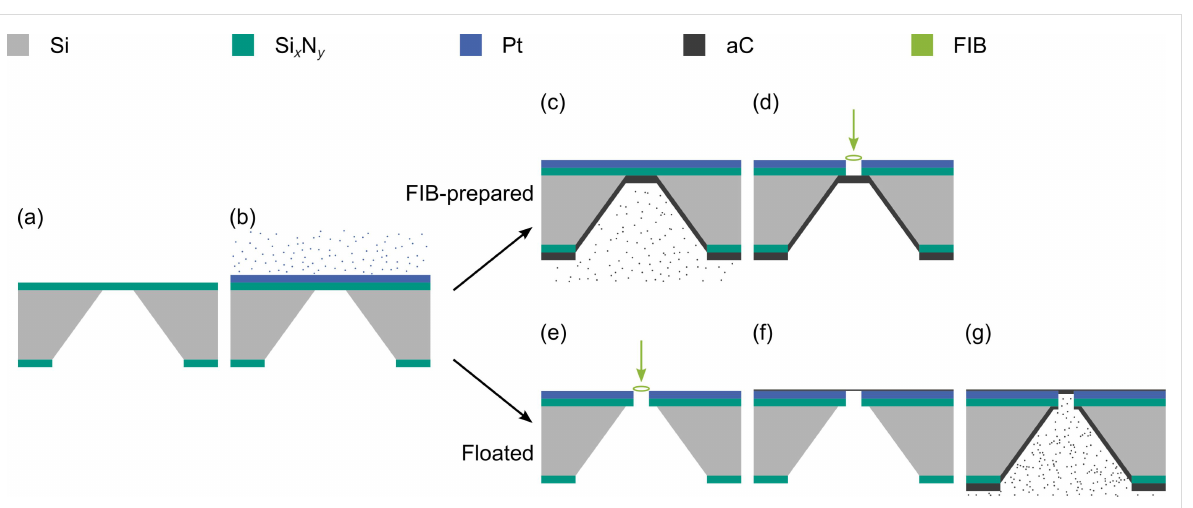
Figure 2: The fabrication steps to fabricate aC thin films are schematically shown for the two applied methods. (a) Si x N y membranes prepared by optical lithography are (b) covered with Pt (ca. 220 nm). (c) For the “FIB-prepared” method, aC is deposited on the back side and (d) FIB milling is used to remove Pt and Si x N y . The milling is stopped at the homogeneous aC layer. (e) Alternatively, for the “Floated” method, apertures are first created by FIB milling. (f) Amorphous carbon thin films are then floated onto the samples. (g) The thickness of the aC thin films is increased by evapo- ration of